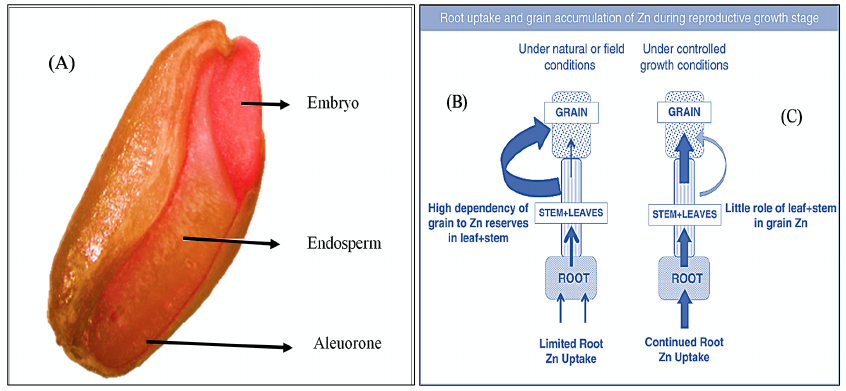
Figure 1 ( A ) Localization of Zn in wheat grains, visualized with dithizone as a Zn-sensing dye that develops a red complex with Zn. The intensity of the red color is associated with the Zn concentration [see Ozturk et al. 2006]. ( B ) Zn uptake and retranslocation from root to vegetative organs and then to grains in wheat plants under limited water or Zn availability or both during seed-filling and ( C ) under controlled growth conditions with adequate water and Zn supply. Source: Cakmak & Kutman (2018)